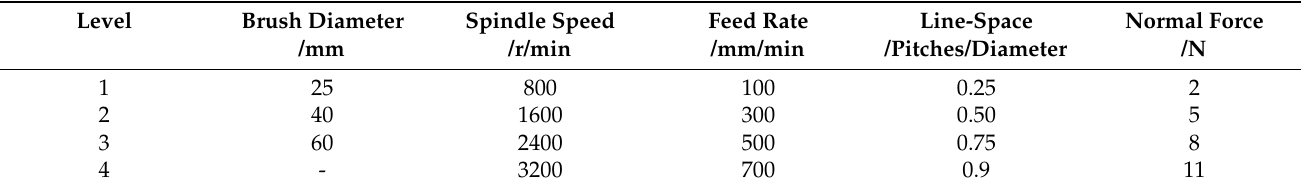
Table 1. The Process Parameters and Their